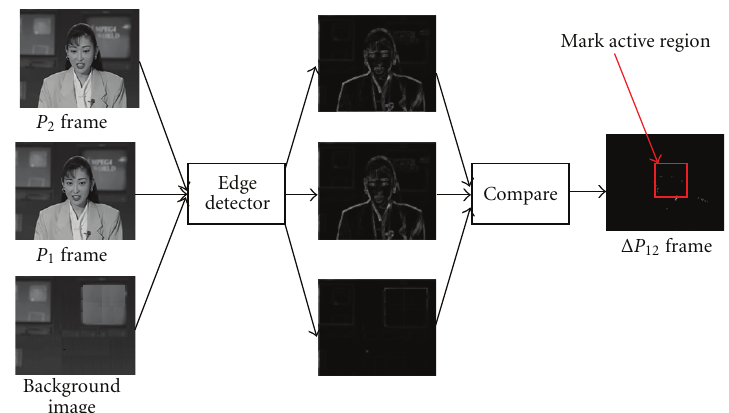
Figure 6: Comparing the edges of objects in the frames to mark active regions.